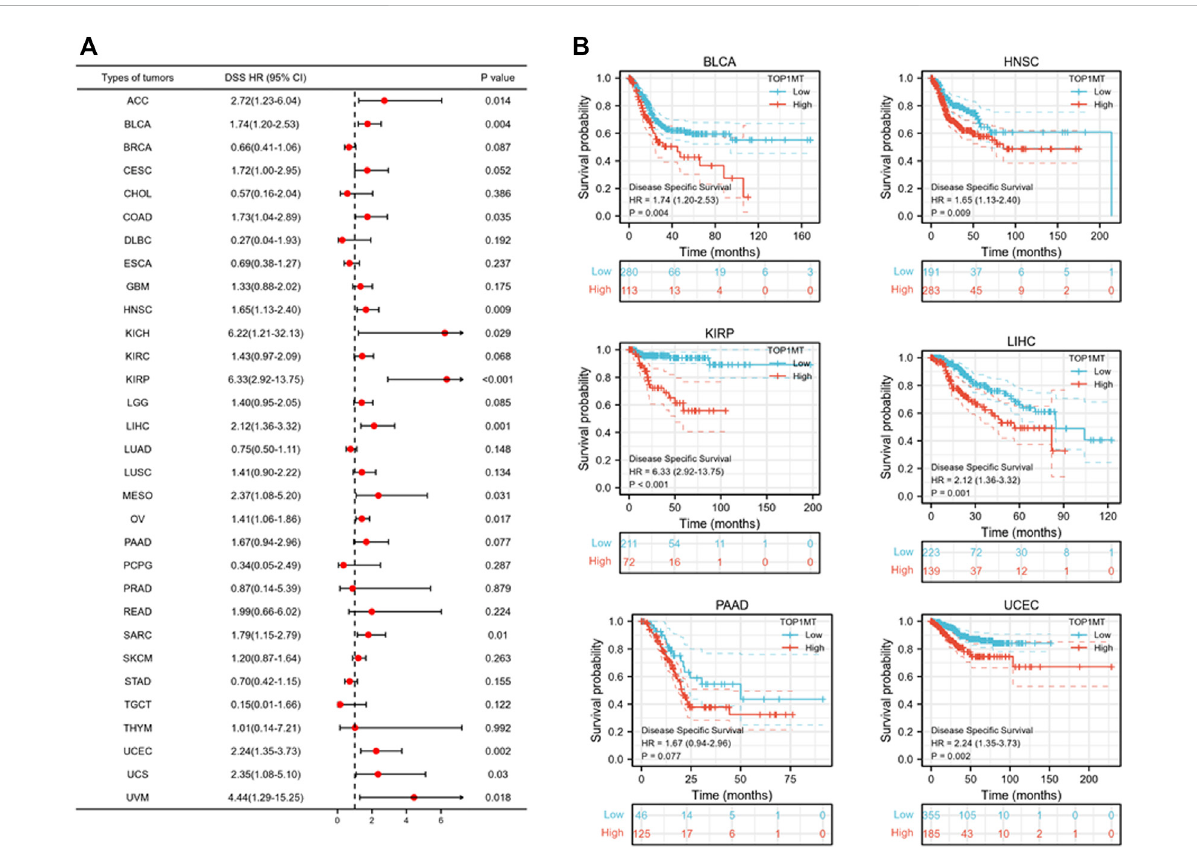
FIGURE 3 Relationship between TOP1MT expression and DSS in cancer patients. (A) Forest map of TOP1MT risk ratios in 33 tumors; (B) Kaplan-Meier survival curve of DSS in PATIENTS with BLCA, HNSC, KIPP, PAAD, UCEC, and LIHC. p p < 0.05, pp p < 0.01 and pp p <